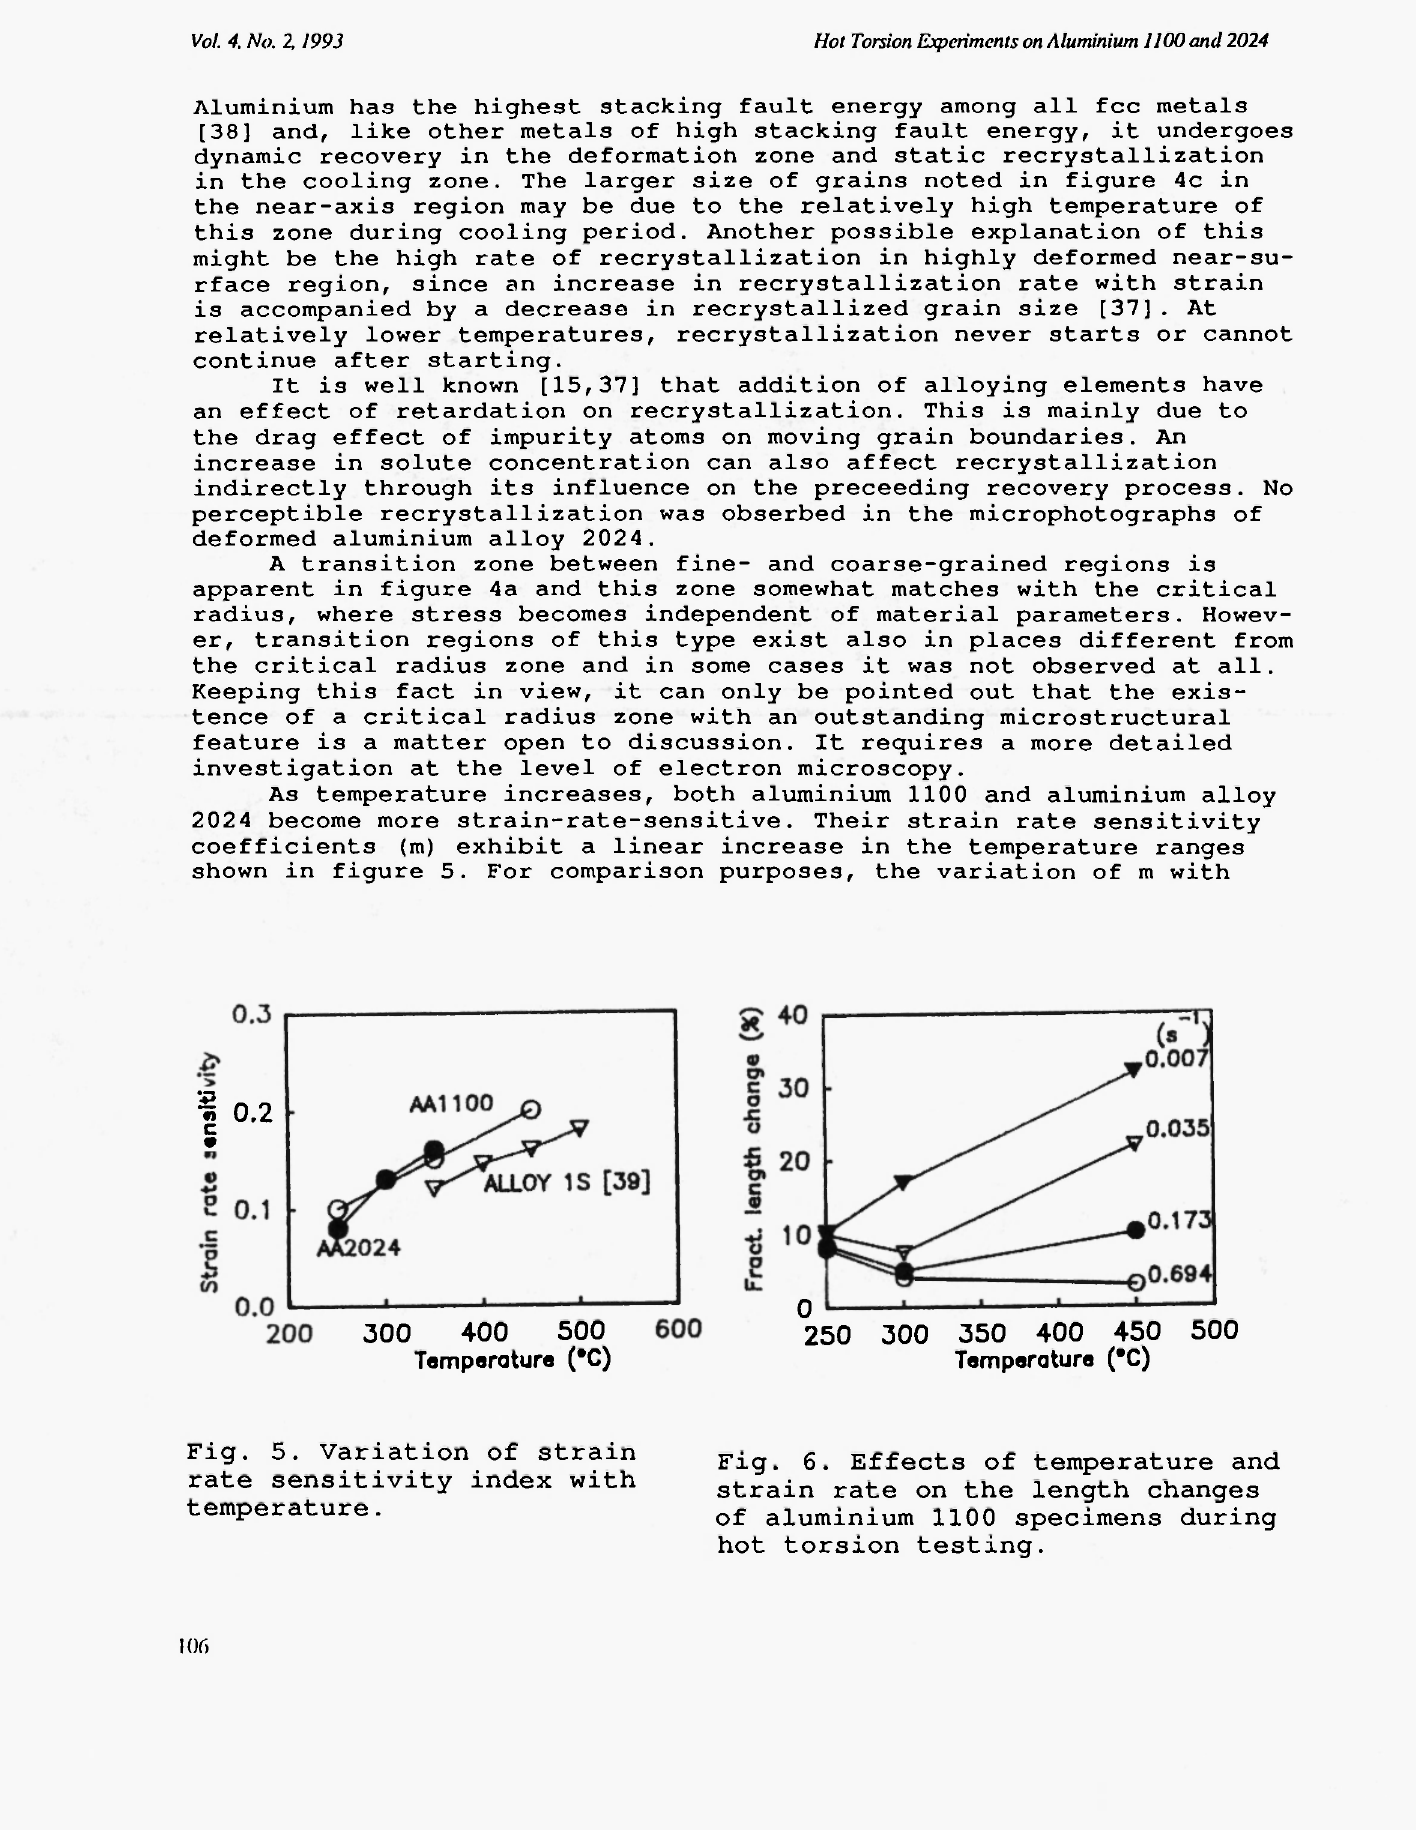
Fig. 6. Effects of temperature and strain rate on the length changes of aluminium 1100 specimens during hot torsion